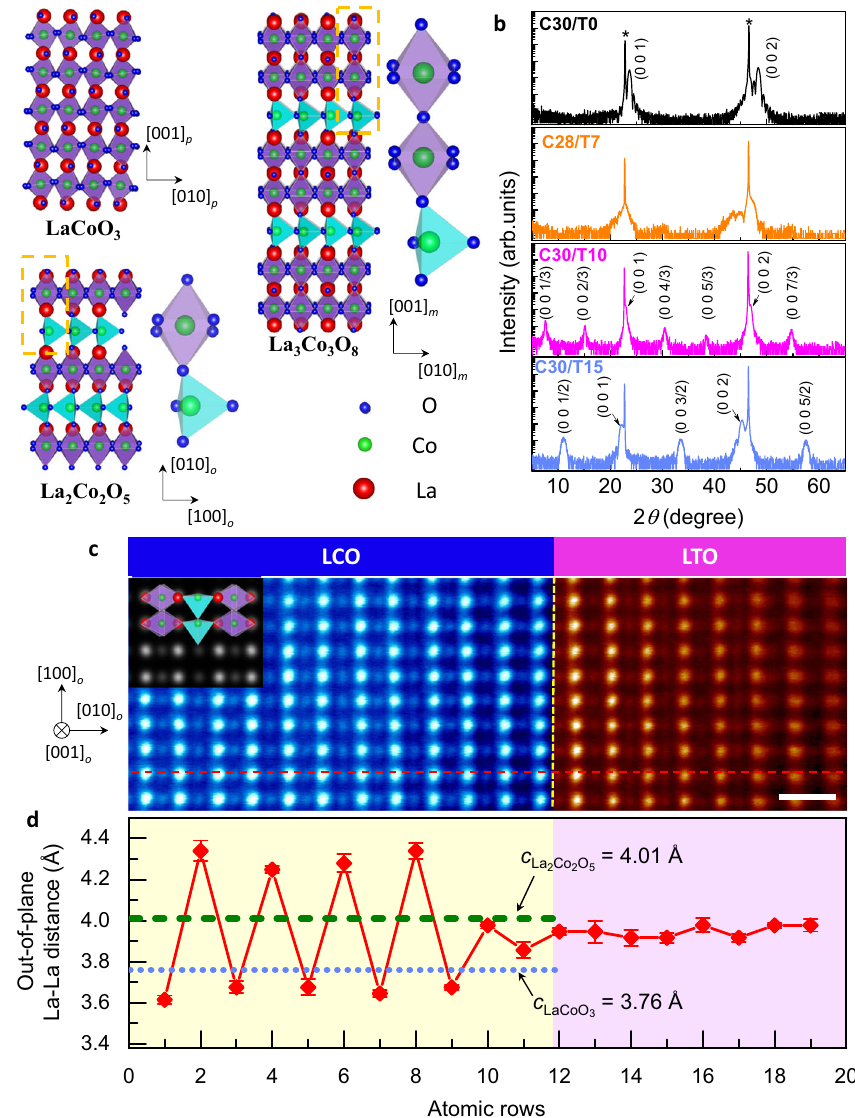
Fig. 3 Topotactic phase transition in C30/T n . a Schematic crystal structure of perovskite LaCoO 3 , La 3 Co 3 O 8 , and brownmillerite La 2 Co 2 O 5 , respectively. Enlarged details are presented to show the stacking sequence of CoO 6 octahedrons and CoO 4 tetrahedrons along the out-of-plane direction. b X-ray diffraction data of LCO/LTO heterostructures. Blackline, C30/T0; orange line, C28/T7; magenta line, C30/T10; light blue line, C30/T15. All indices correspond to the averaged perovskite u.c. Peaks from STO substrates are denoted by asterisks. c High-resolution high-angle annular dark- fi eld scanning transmission electron microscopy (HAADF-STEM) image of C30/T15 taken along the STO [110] direction. The scale bar corresponds to 0.5 nm. The inset image shows a simulated STEM image viewed along the [001] o direction based on the structure of brownmillerite La 2 Co 2 O 5 . The yellow dashed line indicates the LCO/LTO interface, while the red dashed line shows the region used to calculate La – La interatomic distances. d Out-of-plane La – La distance along the red dashed line shown in c . The error bar shows the standard deviations of the averaged measurements. The cyan dotted line and green dashed line indicates the out-of-plane lattice parameter of LaCoO 3 (C30/T0) and La 2 Co 2 O 5 (C30/T15) obtained from b , process in LCO where the initial CoO 4 sub-layer diffuses into the shows a signi fi cant energy lowering. When 1u.c. of LTO is grown on the LCO, interfacial electron transfer occurs and induces the formation of a CoO 4 tetrahedral sub-layer. As shown in Fig. 1g, layer at the interface. This consecutive process results in the after the interfacial charge transfer the fi nal equilibrium state is ordered distribution of the CoO 4 sub-layers inserted into the a balanced charge state near the interface with the perovskite LaCo 2 + O 3 and LaTi 4 + O 3 . However, interfacial charge transfer would trigger the phase transition of LCO, then the electrostatic charge at the LCO side could be eliminated. Increasing the LTO thickness, charge transfer might occur between LaTi 4 + O 3 at the interface and following LaTi 3 + O 3 . Due to there still has electron at Ti d -band and the uncharged LCO at the interface, consecutive charge transfer across the LCO/LTO interface and the kinetic